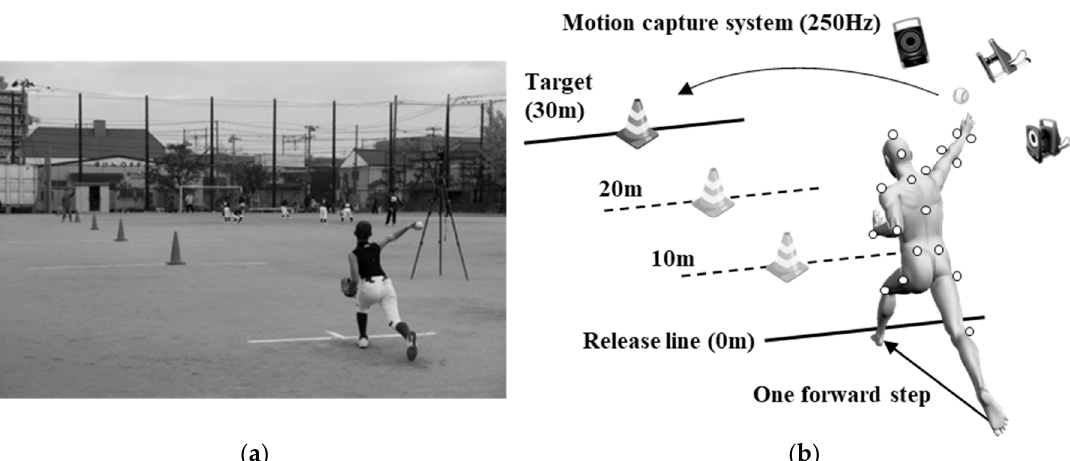
Figure 1. Test procedure. ( a ) Long-toss test, ( b ) Capture of throwing motion during